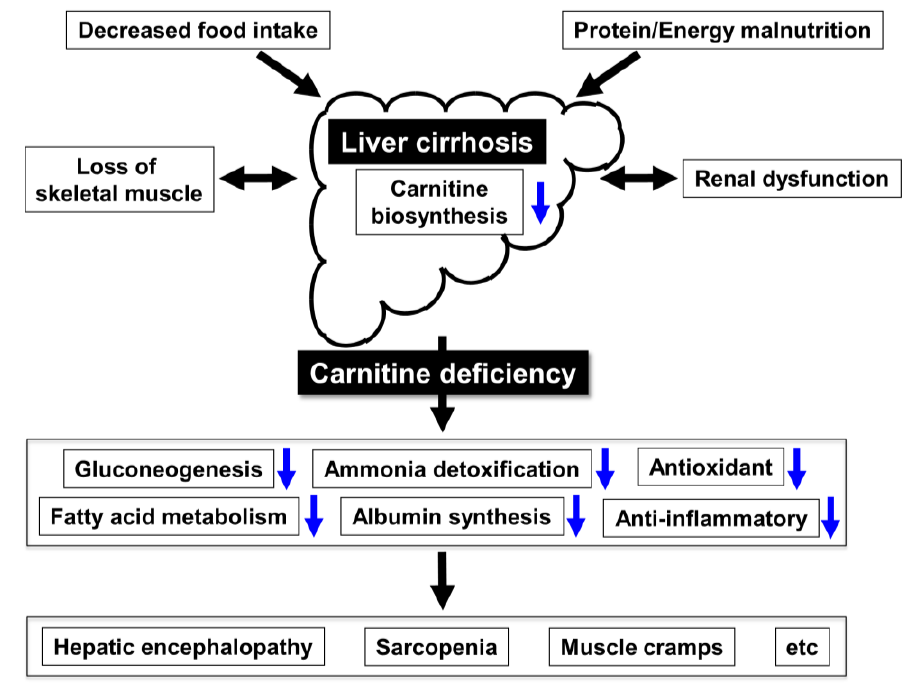
Figure 1. Carnitine deficiency and liver cirrhosis.